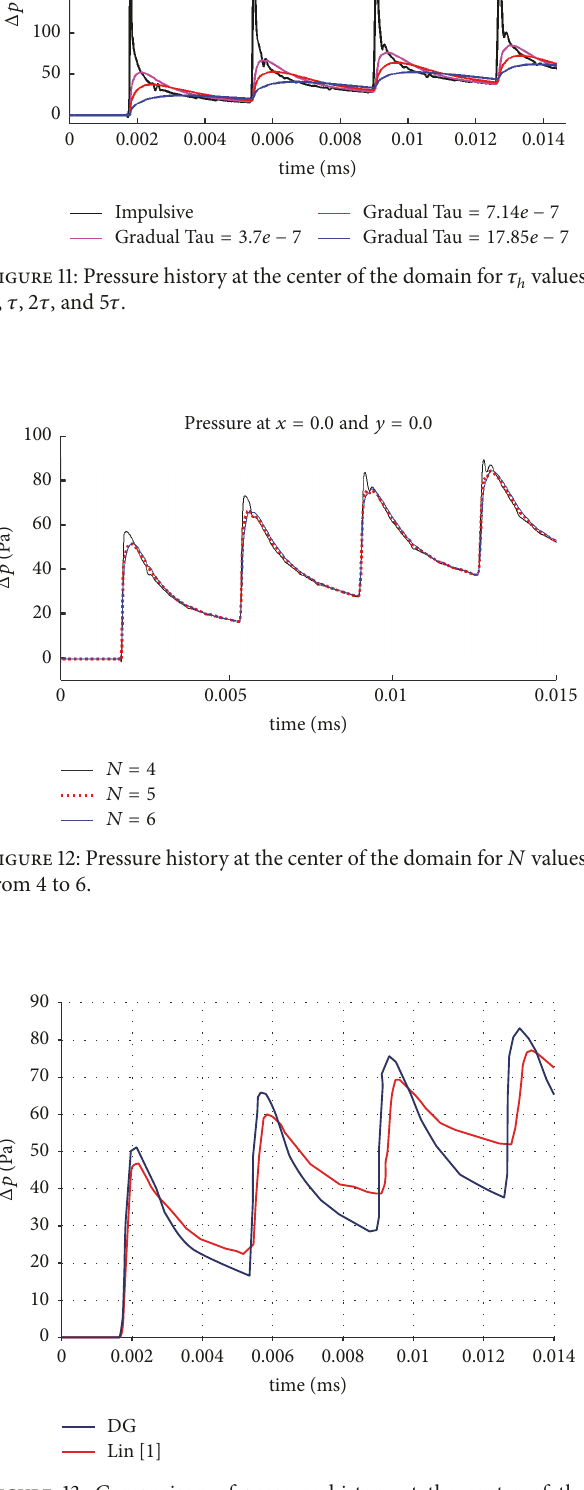
Figure 13: Comparison of pressure history at the center of the domain of the DG method and the finite volume FCT method